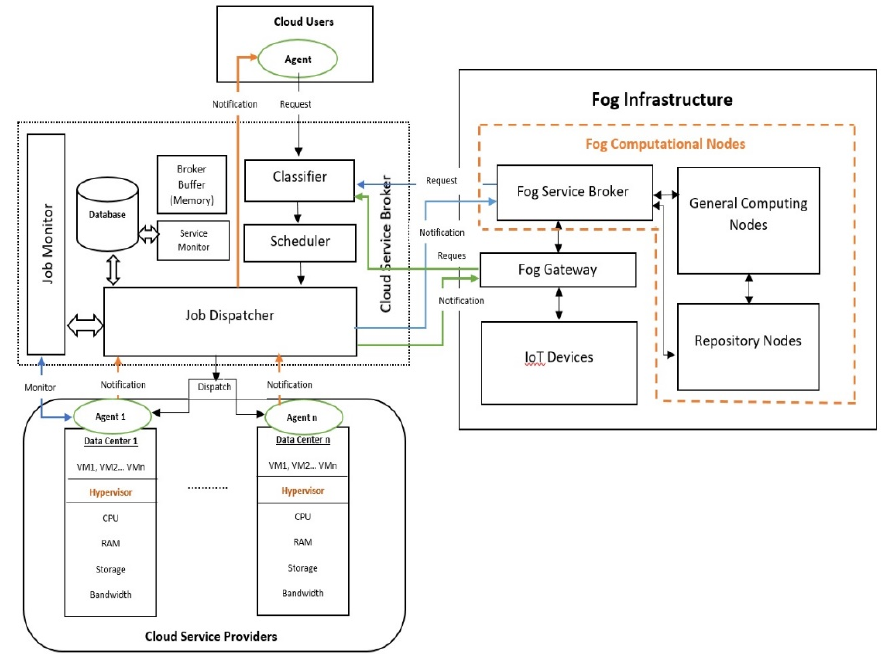
Figure 7. Architecture of Dynamic Congestion Management Brokering (DCMB) System.